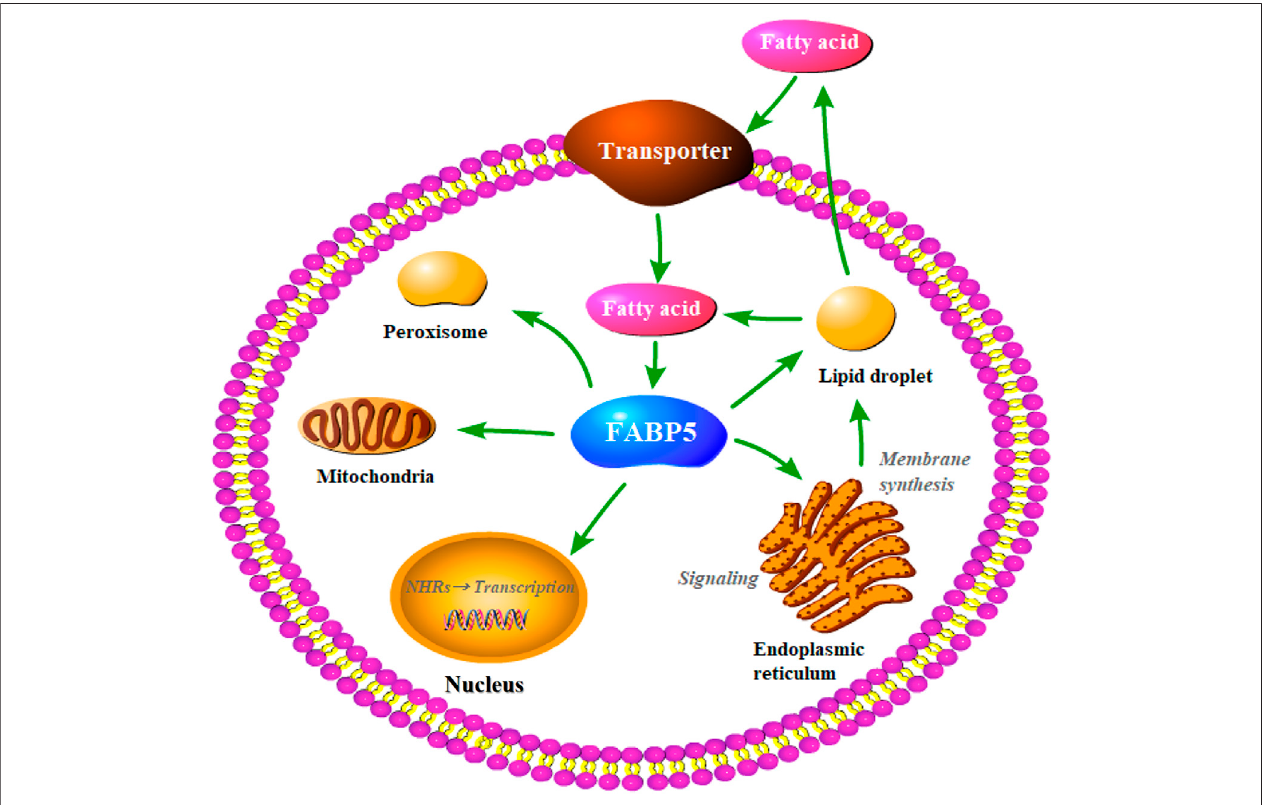
FIGURE 1 | Putative functions of FABP5 in the cell. As lipid chaperones, FABP5 may actively facilitate lipid transportion to speci fi c intracellular compartments and thereby realize different biological functions, such as the lipid droplet storage, signaling transduction, traf fi cking and membrane synthesis in endoplasmic reticulum, oxidation in mitochondria or peroxisome, lipid-mediated transcriptional regulation in the nucleus, or even signaling in an autocrine or paracrine manner outside the cell.